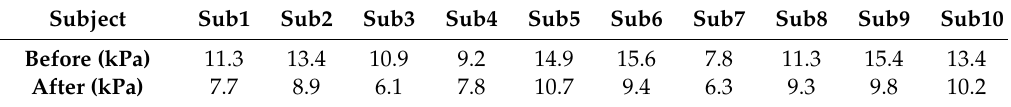
Table 12. Changes of the instantaneous